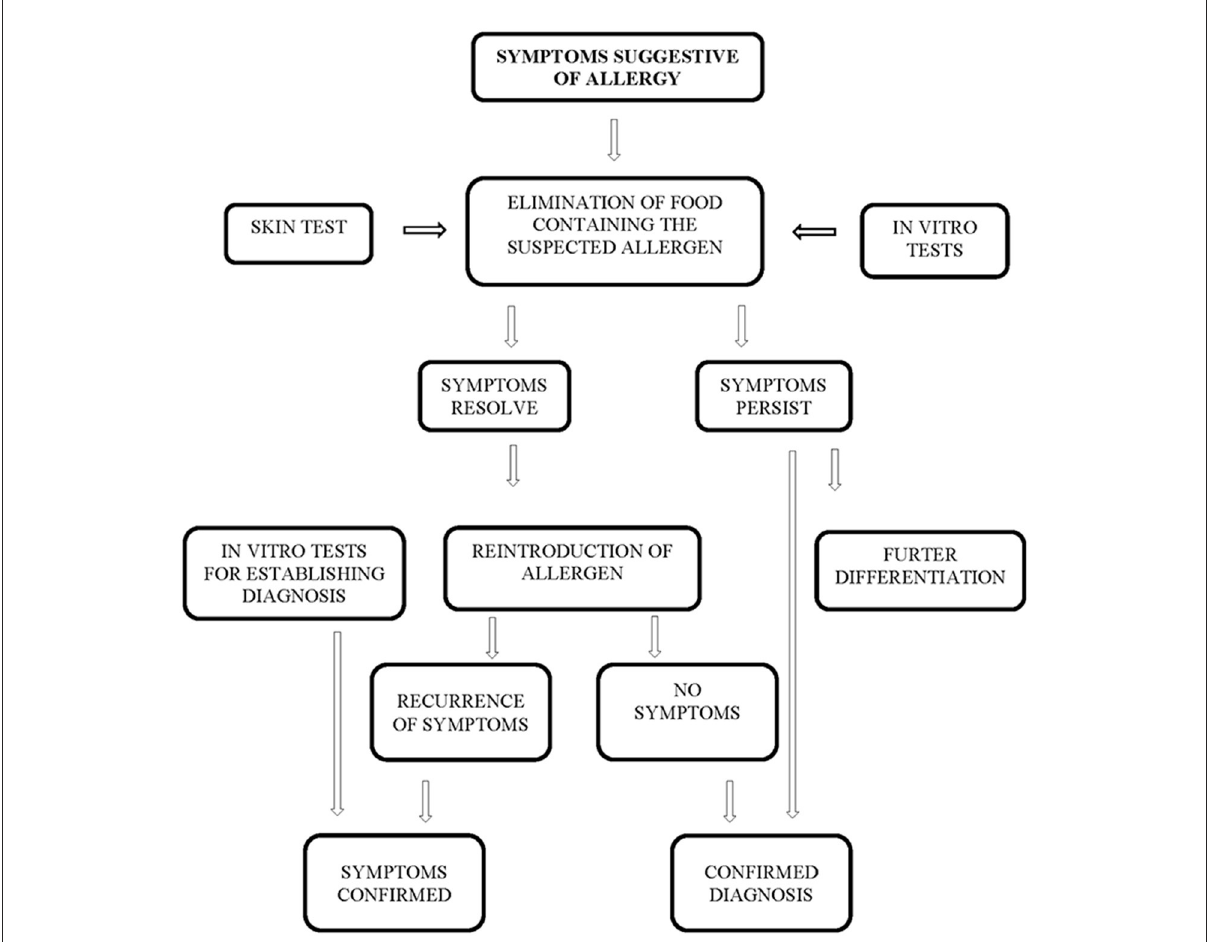
FIGURE1 Diagnostic algorithm for establishing the diagnosis of nutritional